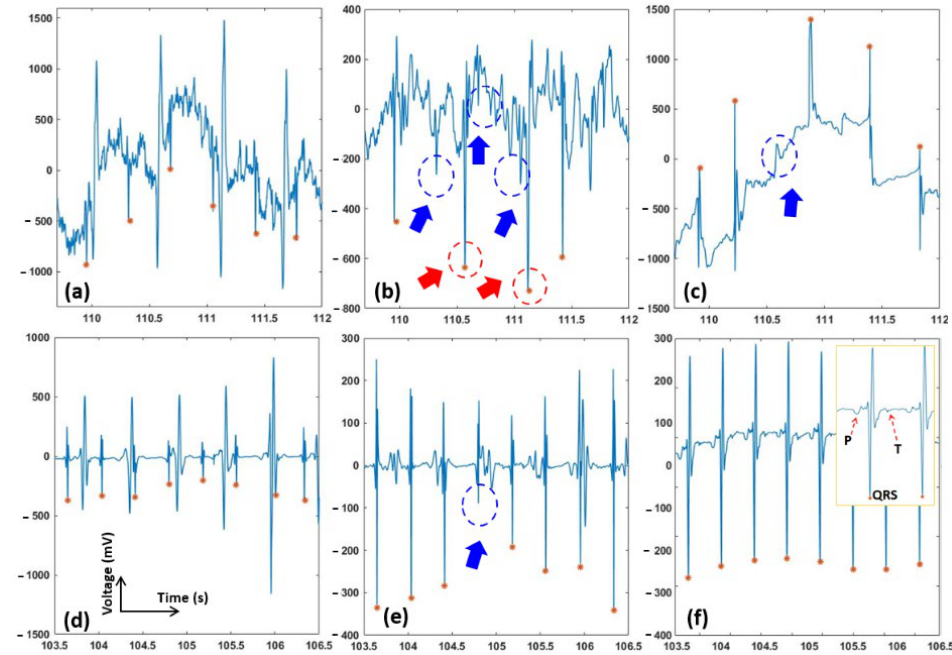
Figure 6. fECG extraction using the EKF and EnKF with our own clinical data. The fQRS annotation is shown in orange asterisk (*). The red arrows show the places that fetal QRS was wrongly detected. The blue arrows show the missing fetal QRS. ( a ) Abdominal ECG (raw data), ( b ) fECG extracted from EKF and ( c ) fECG extracted from EnKF”. ( d ) Abdominal ECG after Wavelet preprocessing; ( e ) fECG extracted using EKF of preprocessed data; and ( f ) fECG extracted using EnKF of preprocessed data. The inset shows additional peaks, likely P and T waves; they were conserved after EnKF extraction. Another parameter that should be taken into account is the computational